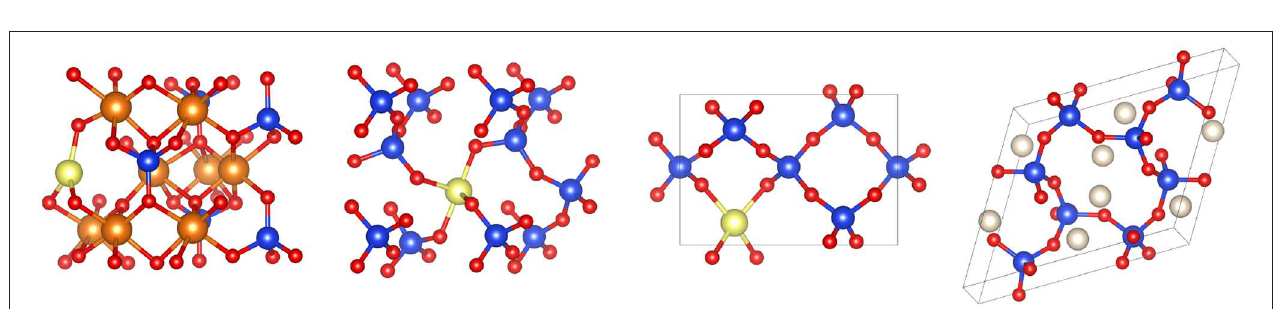
FIGURE 2 | Experimentally synthesized noble gas-silicates. From left to right: Xe-doped olivine Mg 2 SiO 4 [42], Xe-doped β -quartz [43], (Xe,Si)O 2 phase for which Xe site occupancy is unknown [ 43], cristobalite-He [41]. Color code for atoms: magnesium (orange), xenon (yellow), oxygen (red), silicon (dark blue), helium (white).